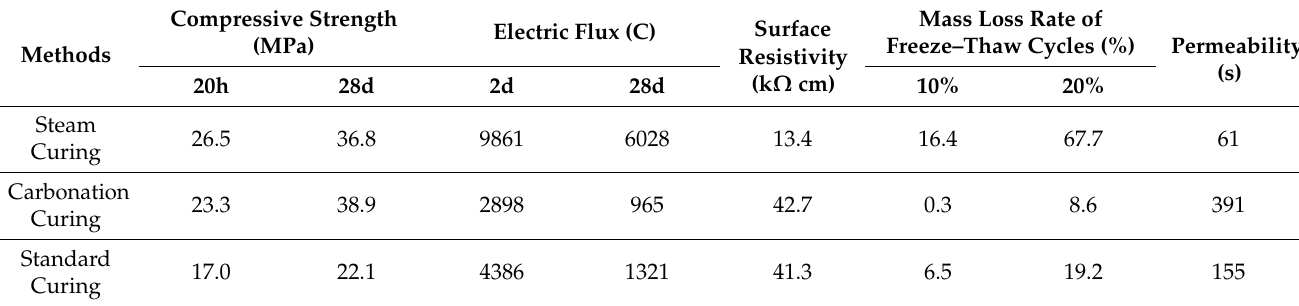
Table 2. Comparison of the effects of carbonation curing and steam curing [27].